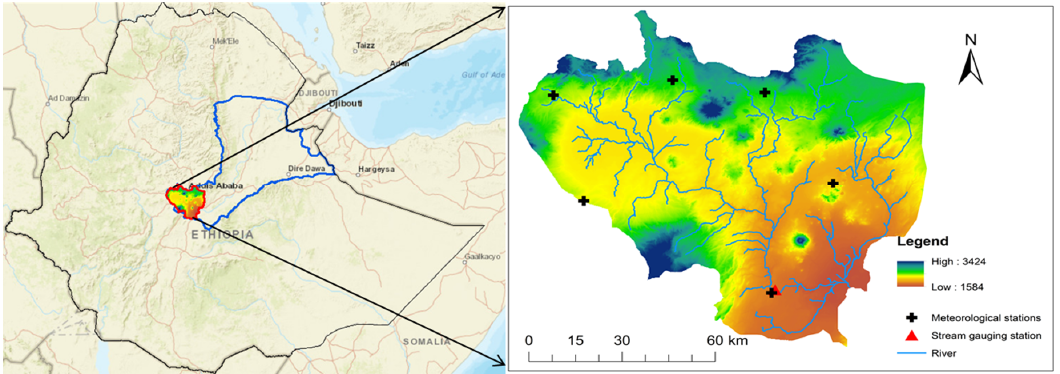
Figure 1. Study area location of the Upper Awash River Basin.